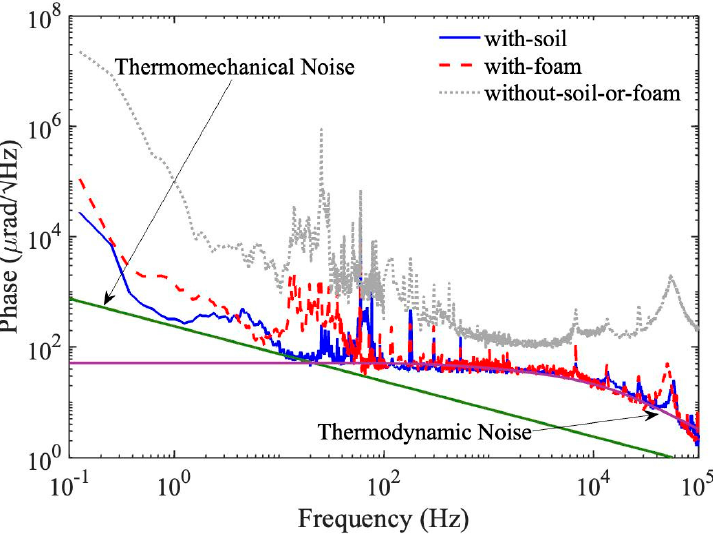
Figure 5. A comparison between the noise spectra of the MZ − FP interferometer with soil (solid) and with polyurethane foam (dashed) as the insulation material. The noise floor measured without either soil or foam is plotted as a reference. Additionally displayed are the theoretically predicted thermodynamic and thermomechanical noises due to spontaneous fluctuations inside the fibers